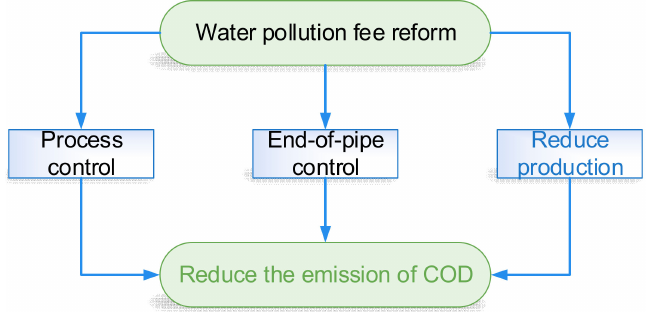
Figure 2. Approach to enterprise emission